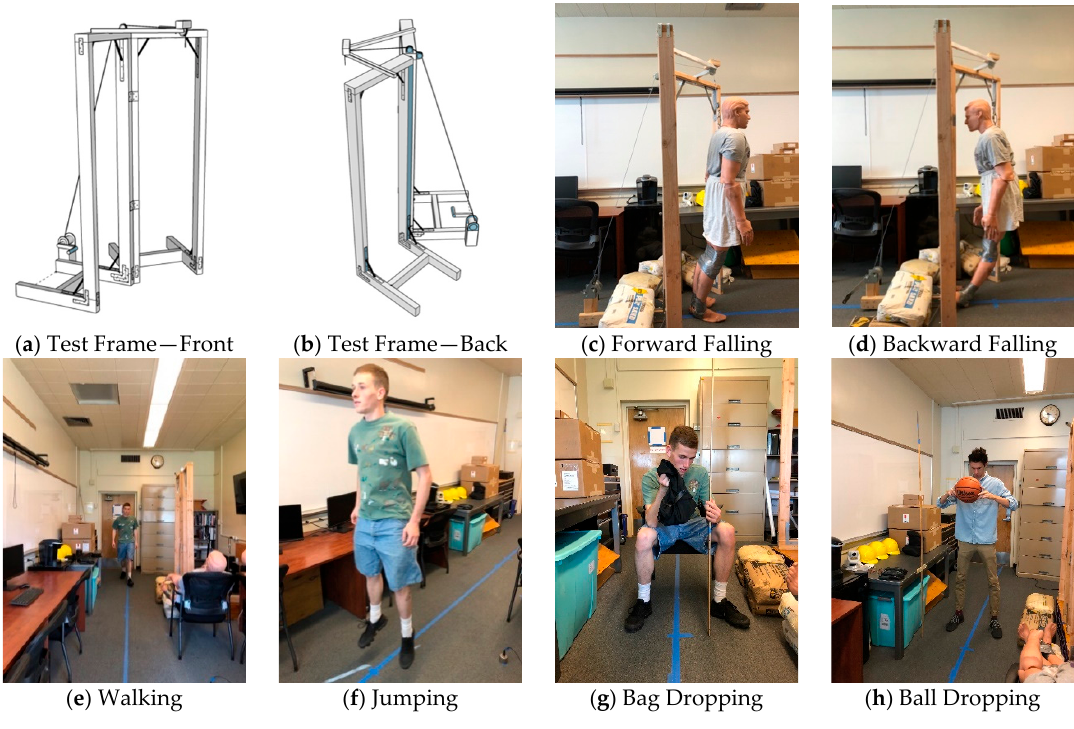
Figure 4. Experiment Setup.